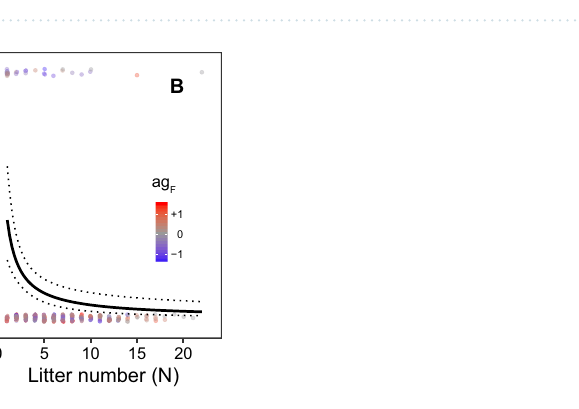
Table 3. Summary of the most parsimonious model for each of the five components of reproductive success. Parameter estimates given as mean with 95% CI in the parentheses. Parameters significantly different from zero (95% CI does not overlap zero) highlighted in bold. Degrees of freedom (df) for the LMMs approximated by the Kenward-Roger method. ag = Agreeableness, co = Conscientiousness; F = female, M = male; dash (–) = parameter not retained in the ‘top model’ set; NA = parameter not included as explanatory for the given response.